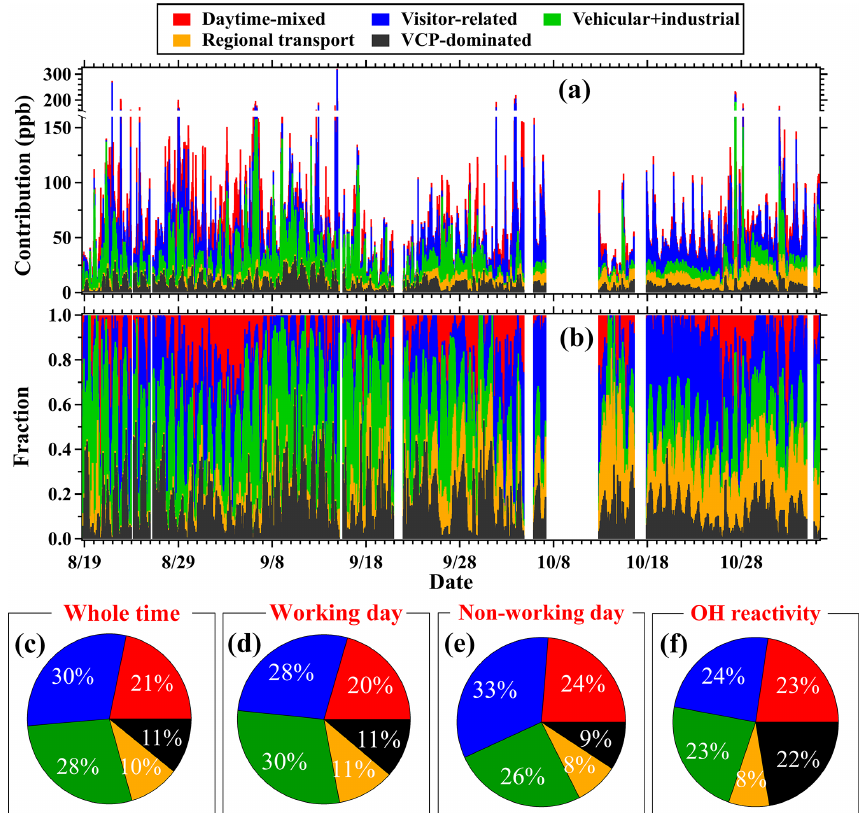
Figure 7. (a, b) Stacked time series of factor fractions and factor contributions for the PMF analysis. (c–e) Average contribution percentages of the five PMF factors to (c–e) the total VOC concentrations in the whole period, working days, and non-working days and (f) the total OH reactivities during the CTT campaign. In panel (d) , only the VOC species that have known reaction rate constants with OH radicals (Table S1) were